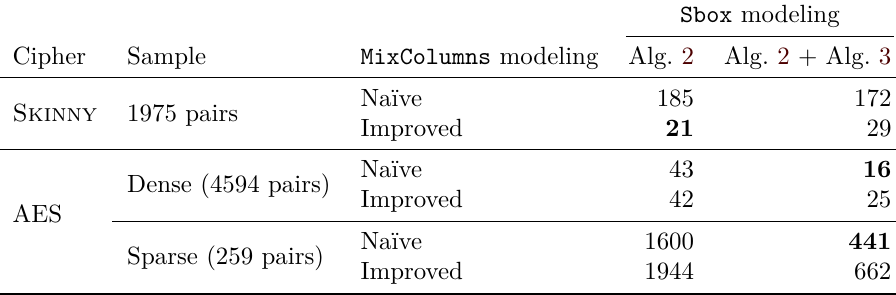
Table 9: Computation time (sec) for 32 rounds of Skinny and 5 rounds of